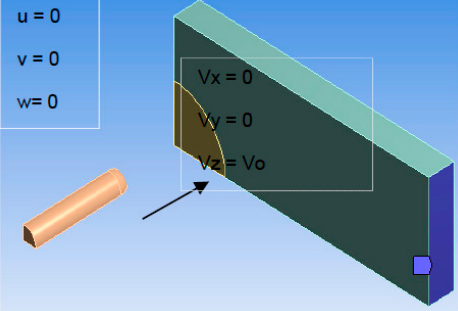
Figure 2. Applied initial and boundary conditions.